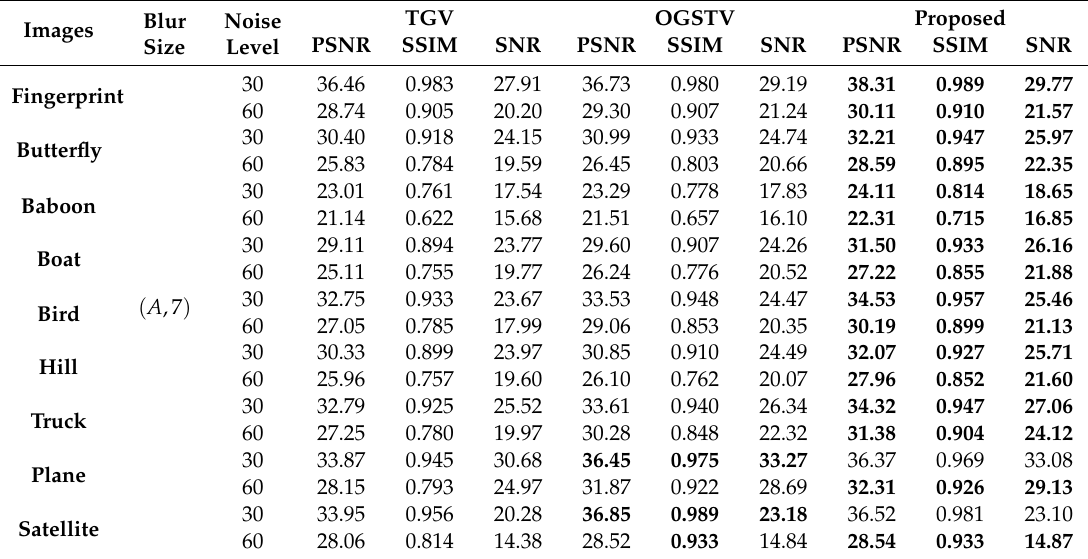
Table 4. Numerical results of PSNR (dB), SSIM, and SNR (dB) for the recovery of nine test images degraded with an average blur kernel ( A ,7 ) and 30–60% impulse noise.